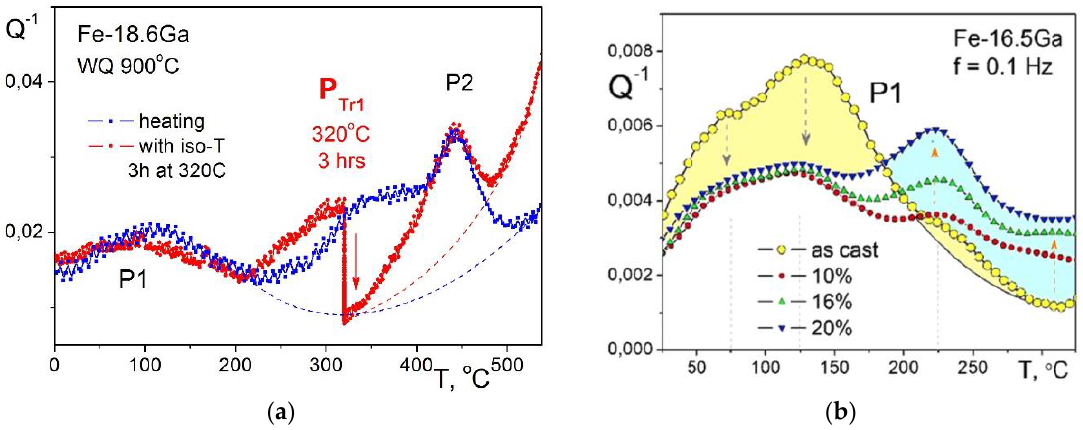
Figure 10. ( a ) Influence of in situ isothermal annealing on the transient peak at 300–350 °C (dotted lines suggest IF behavior in absence of P Tr1 peak) and ( b ) influence of cold work on IF below 300 °C. Figure 11 presents a scheme (based on experimental data [125]) of interfere between P Tr1 , P Z (or P2) Zener, and P Tr1 peaks for three different frequencies measured at heating and cooling. Central P Z (the Zener) peak can be easily seen if we put together TDIF curves at heating (red color) and cooling (blue color). It has nearly Debye shape, and its peak height is normalized to “1”. The P Tr1 and P Tr1 peaks are transient peaks in which height decreases with increase in frequency. This picture helps to understand and predict combination of these peaks at different